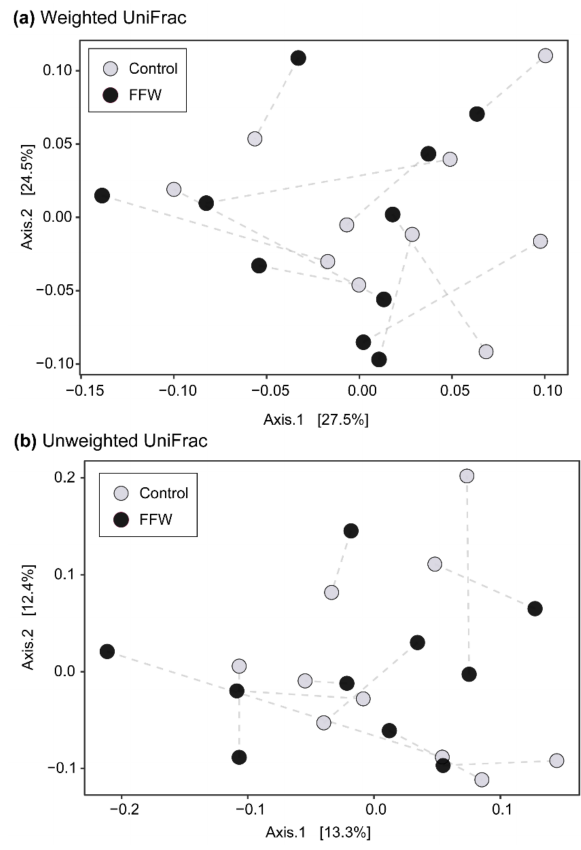
Figure 3. PCoA plots of 16S rRNA gene-based faecal prokaryotic community composition data from FFW and control horses using weighted ( a ) and unweighted ( b ) UniFrac distances. Co-located FFW and control horses are indicated by dashed